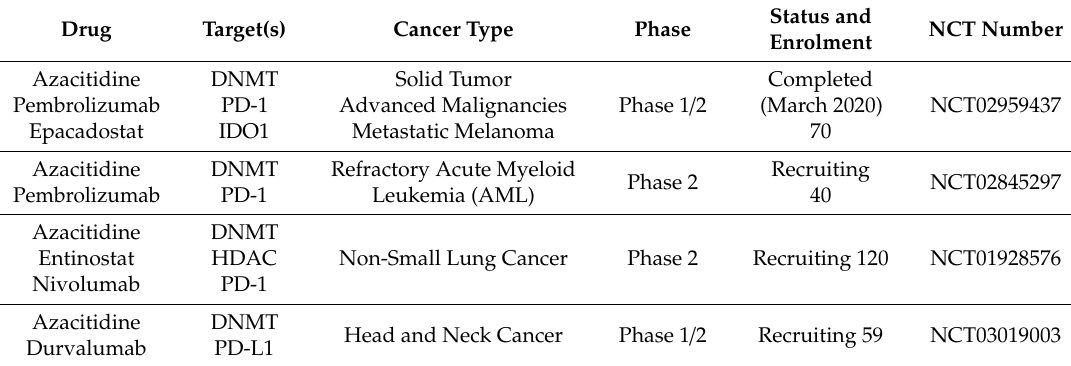
Table 4. Examples of clinical trials combining immunotherapies and epigenetic regulators.